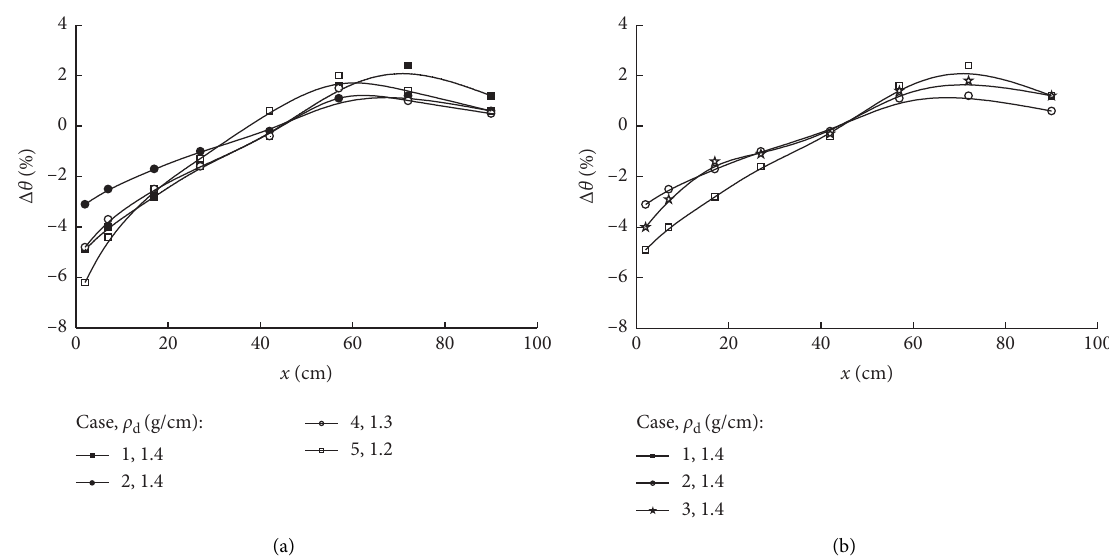
Figure 5: The moisture content variations caused by heating in the different cases ( t � 120h): (a) effect of the dry density and (b) effect of the placement direction.